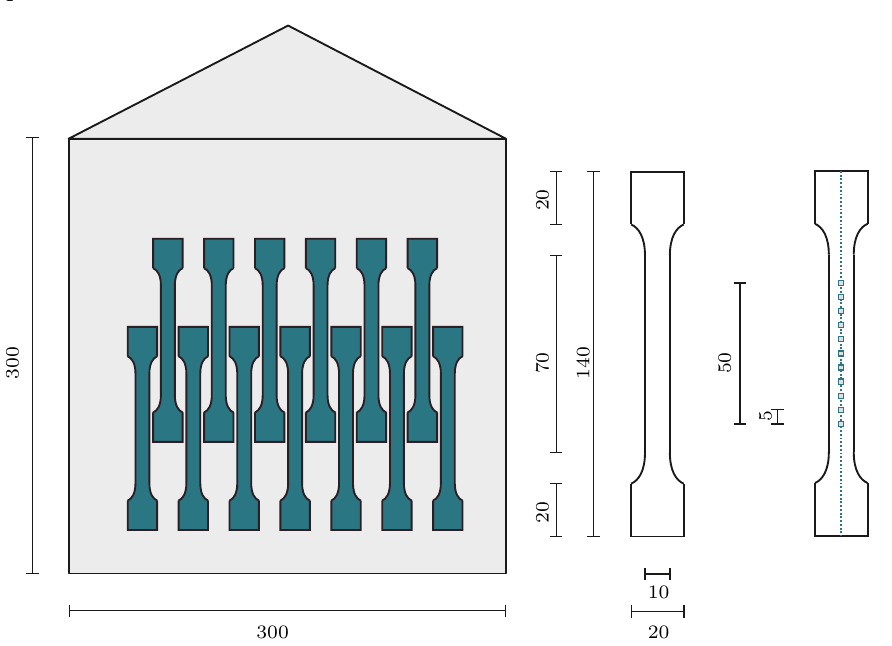
Figure 1. Details of the specimen geometry and the measurement points. All measures in mm, t =